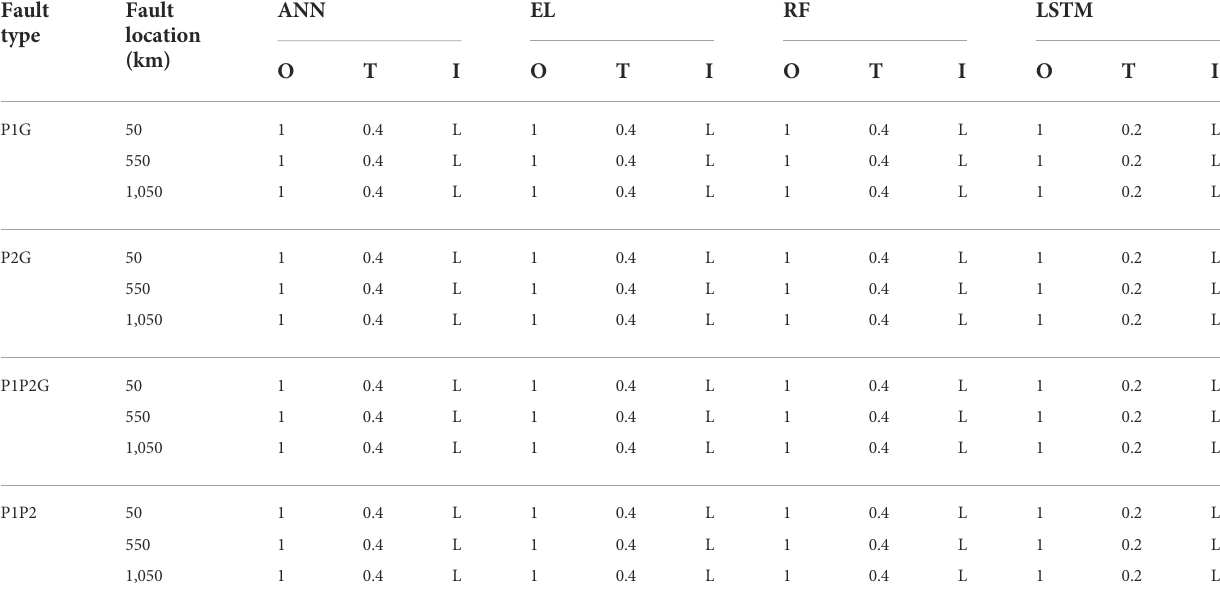
TABLE 3 Performance results during f1 and f2